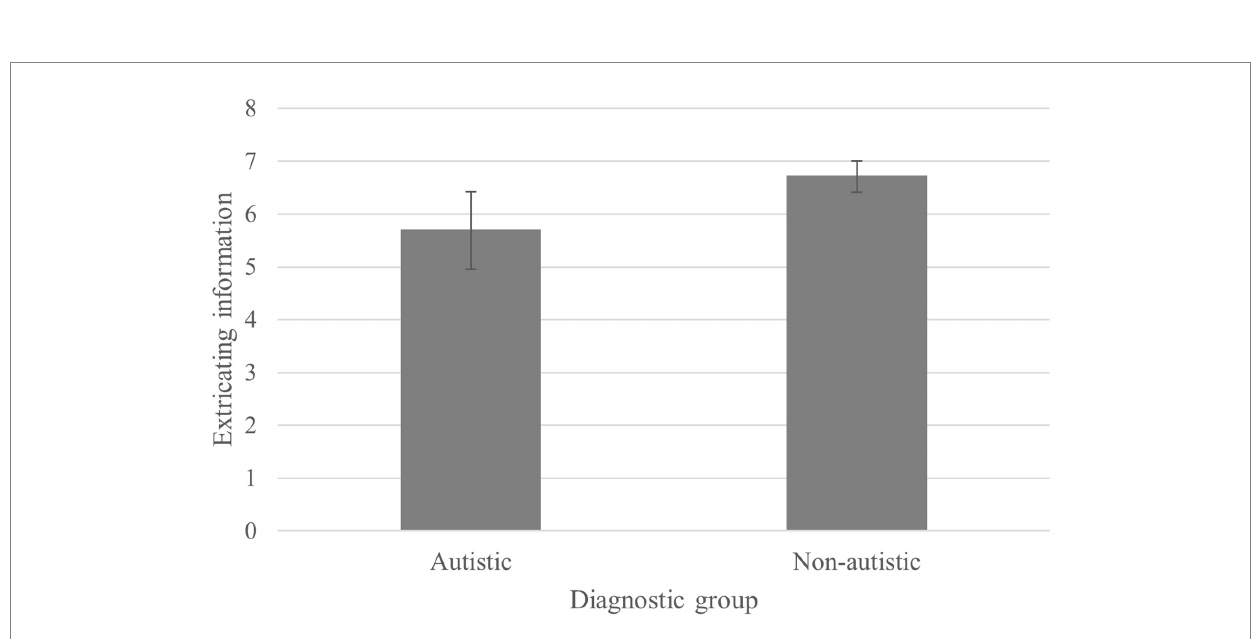
FIGURE 3 Mean extricating information scores for autistic and non-autistic groups in the innocent condition (with BCa 95% confidence error